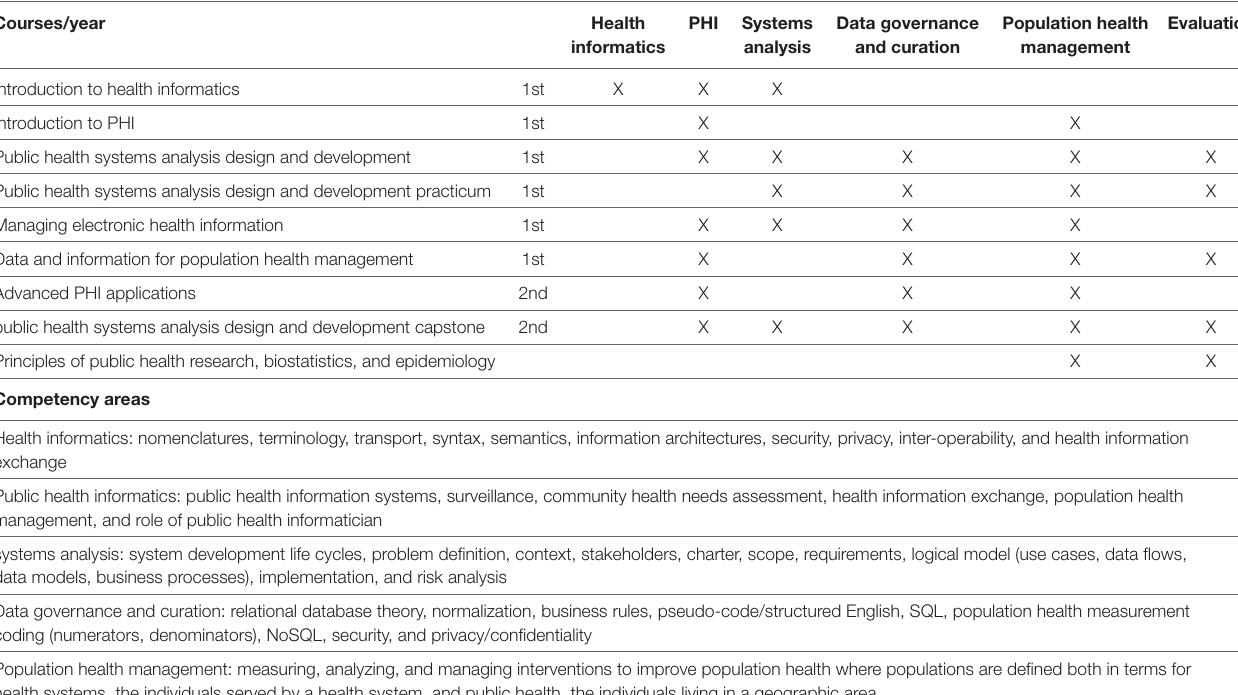
taBle 4 | Public health informatics (PHI) curriculum and competencies.